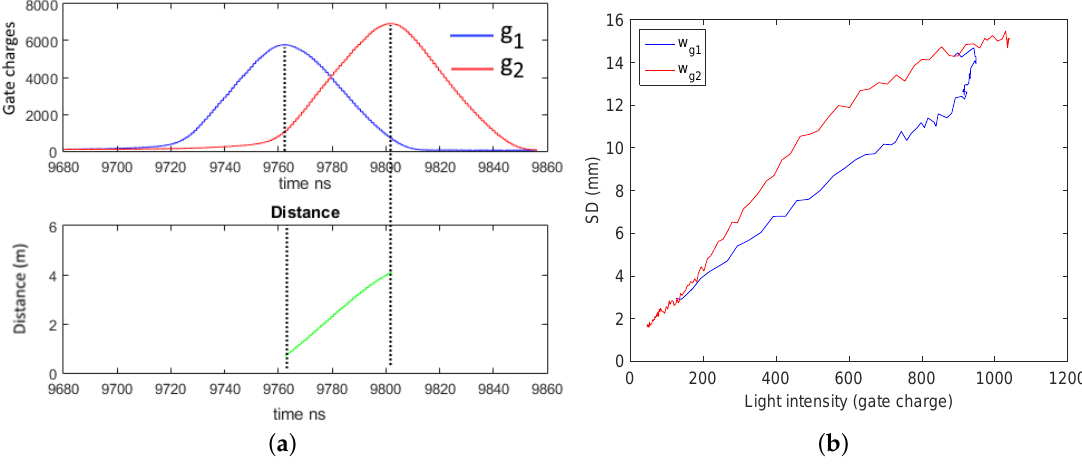
Figure 13. Gate values as a function over distance at constant light intensity ( a ) and the SD for the gate values ( b ). ( a ) Gate charges and distance values; ( b ) SD of gate charges over intensity.